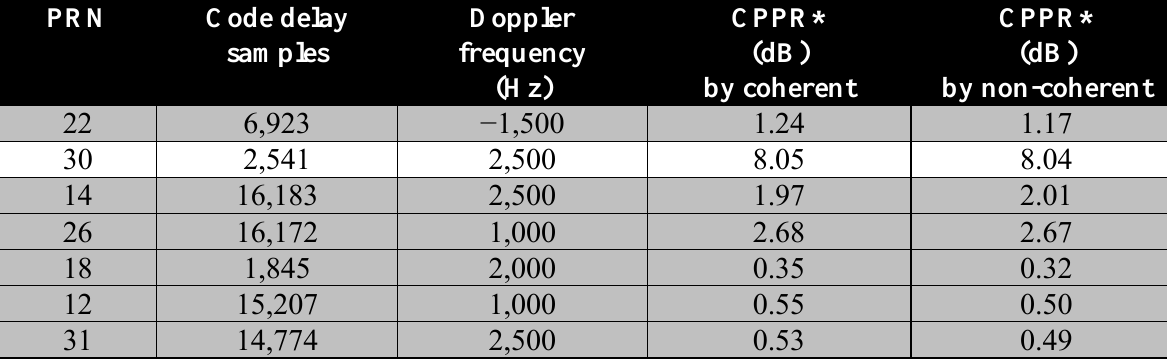
Table 3. The acquisition result of the collected indoor signal by the conventional acquisition method with the coherent and non-coherent integration time of 2 milliseconds.